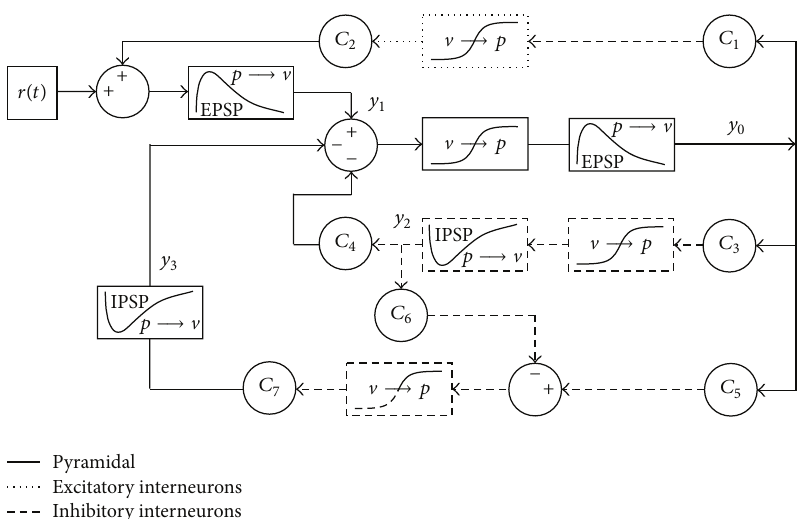
Figure 6: Revised model with additional mathematical reduction. The former 𝑦 4 has been renamed as 𝑦 2 , and the IPSP block for the former 𝑦 2 has been